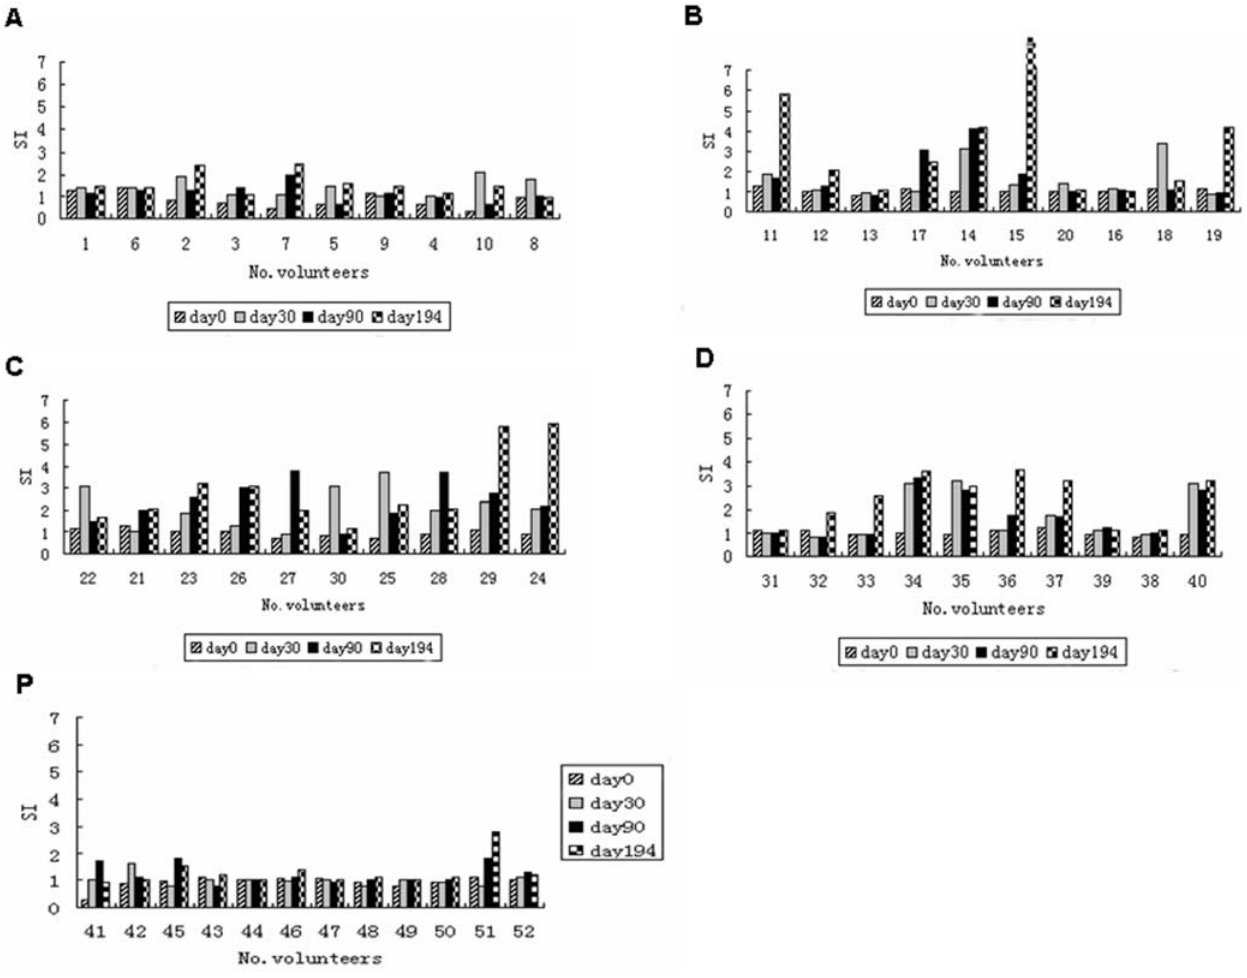
Figure 4. T-cell response to the PfCP-2.9 protein by Lymphocyte Proliferation Assay. Peripheral blood mononuclear cells were separated from blood of participants receiving either the vaccine formulation (group A to D) or the placeb(group P) on the days 0, 30, 90 and 194 and tested for their proliferation. The results were expressed as the stimulation index (SI), SI=mean cpm of culture with the antigen/mean cpm of culture without the antigen.